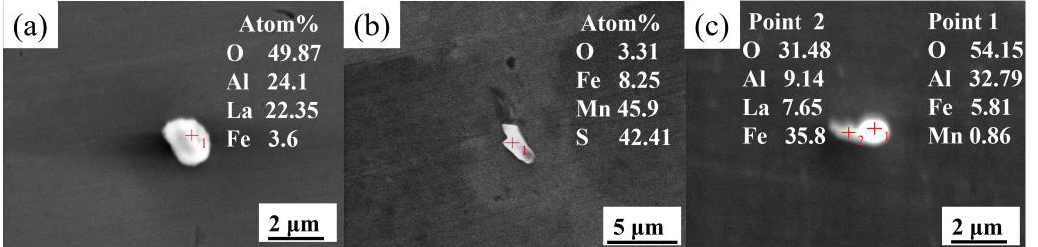
Figure 2. SEM images and EDS results of typical inclusions in steel containing 0.0075 wt.% La: ( a ) LaAlO 3 , ( b ) MnS, and ( c ) Al 2 O 3 -LaAlO 3 complex inclusion.